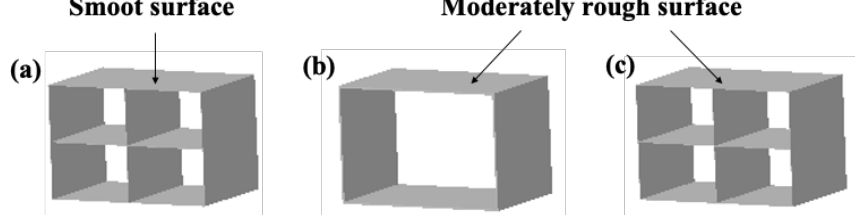
Figure 13. Design of three types of homogenizer: ( a ) multi-channel reflective box, ( b ) conventional scattering box, and ( c ) integrated version termed multi-channel scattering box.